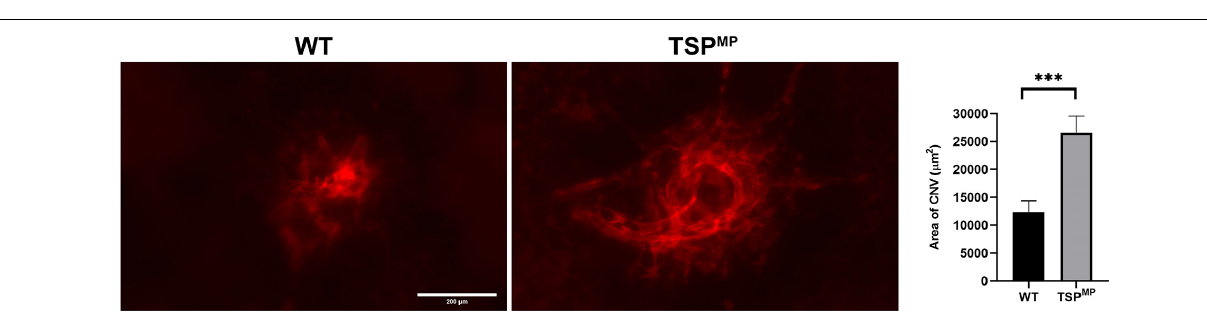
FIGURE 7 | Lack of TSP1 expression in mononuclear phagocytes increases choroidal neovascularization. 6-weeks old male and female Thbs1 wt / wt Lyz2-Cre and Thbs1 Flox / Flox Lyz2-Cre mice were subjected to laser photocoagulation-induced rupture of Bruch’s membrane. At 14 days, the eyes were stained with anti-ICAM-2 and the area of neovascularization quantitated ( ∗∗∗ P < 0.001). Scale bar = 200 µ